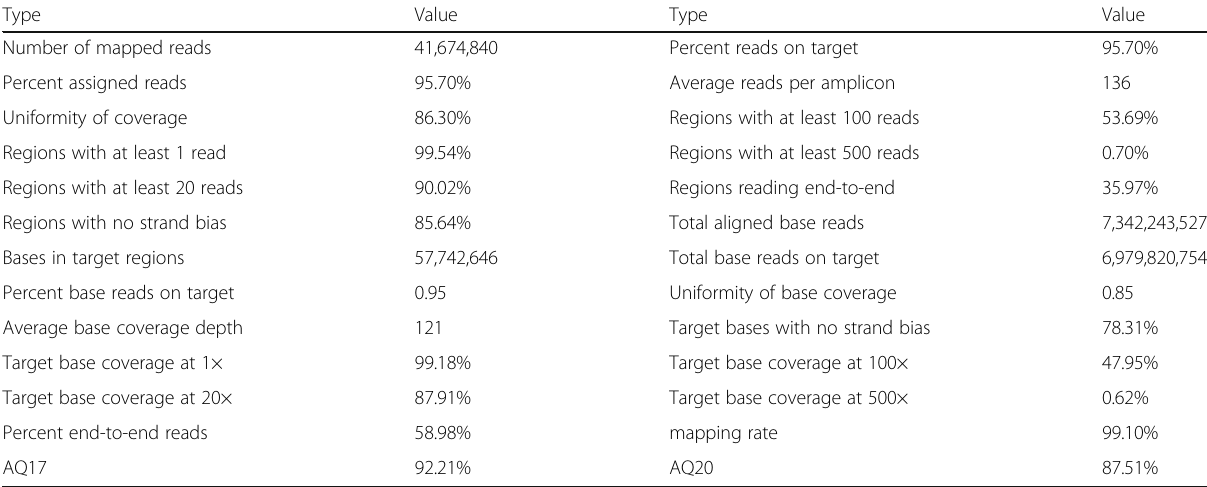
Table 1 Whole exome sequencing detail of coverage and number of